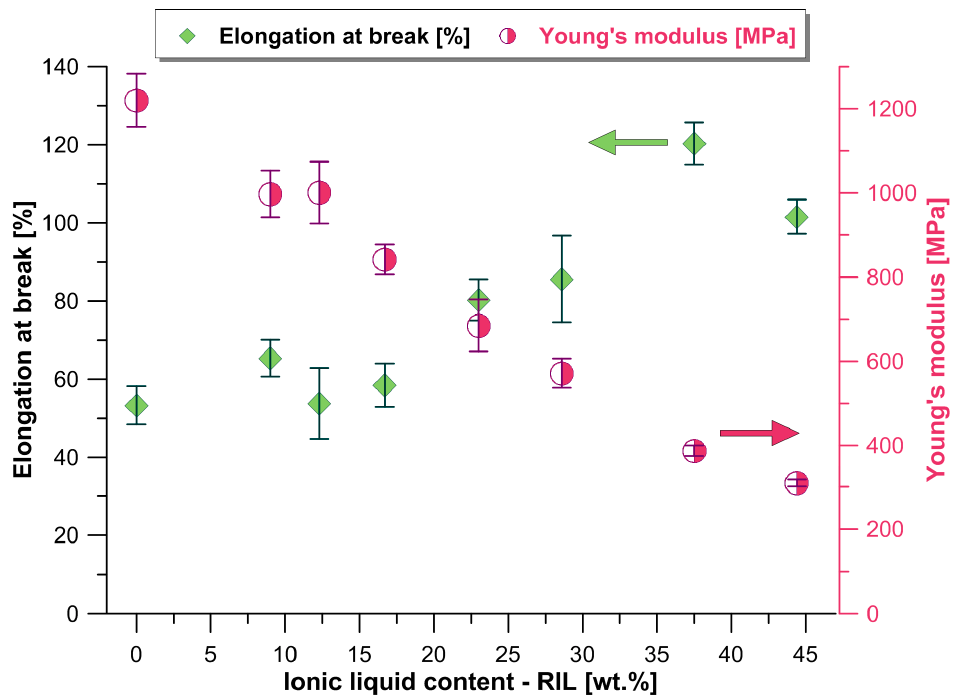
Figure 4. Young’s modulus and elongation at break of cellulose acetate propionate prepared with reactive ionic liquid (CAP-RIL) membranes.